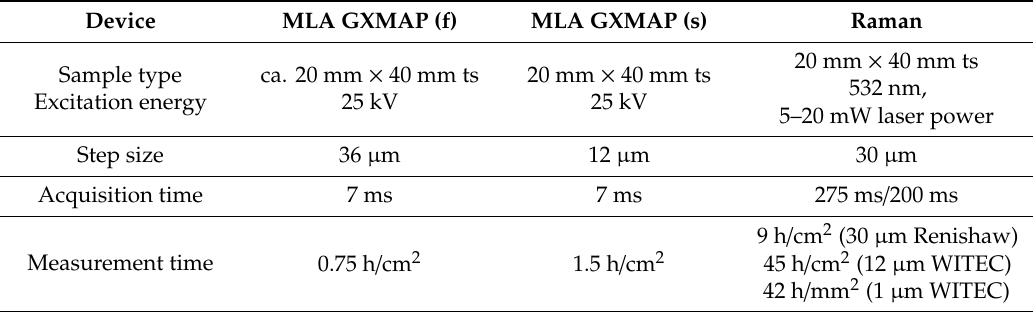
Table 1. Details of the scanning electron microscope (SEM) + mineral liberation analyzer (MLA) and Raman